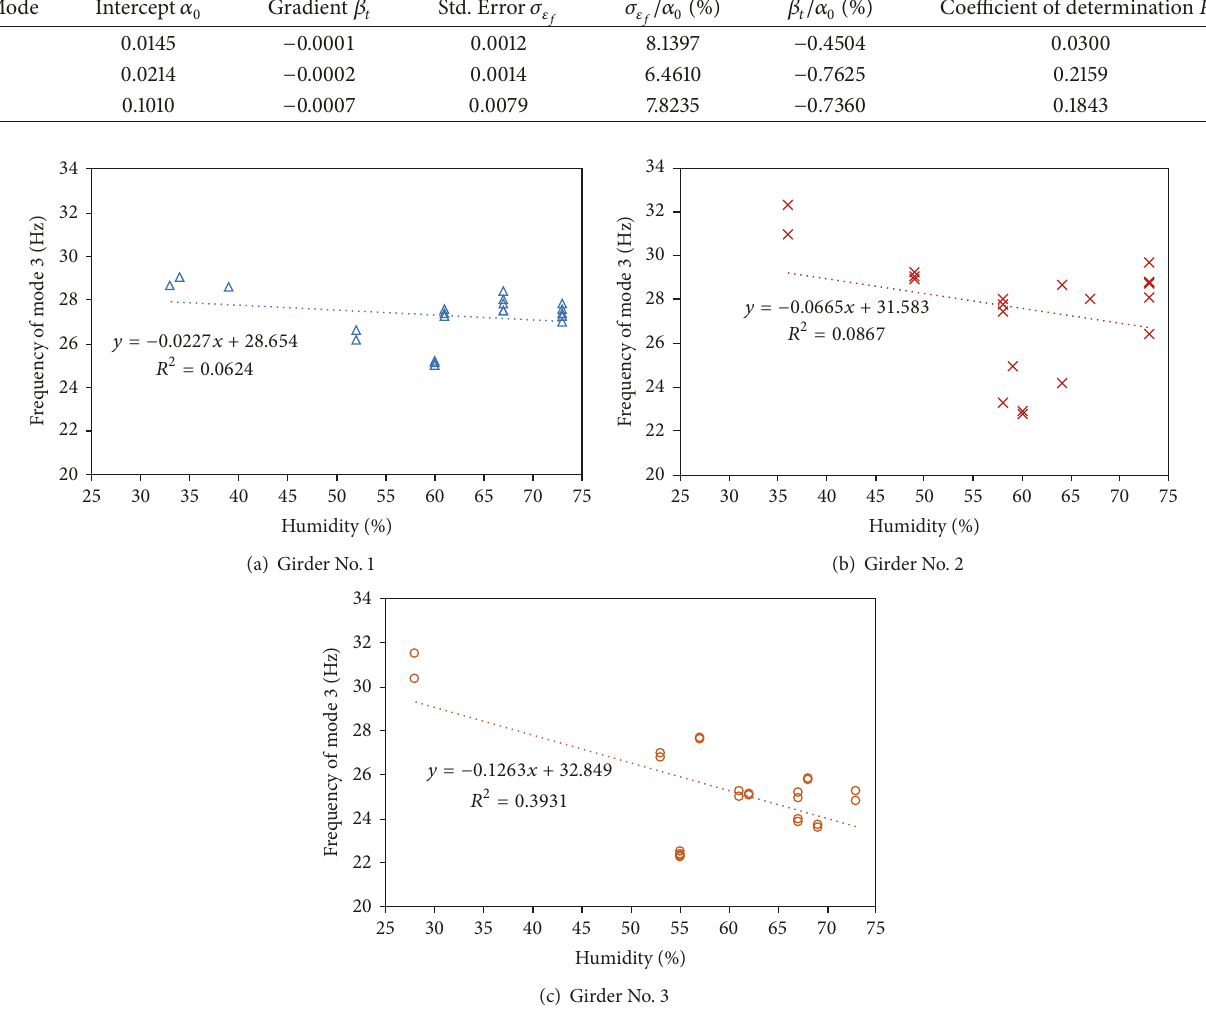
Figure 12: ((a)–(c)) Relation of frequencies of mode 3 to